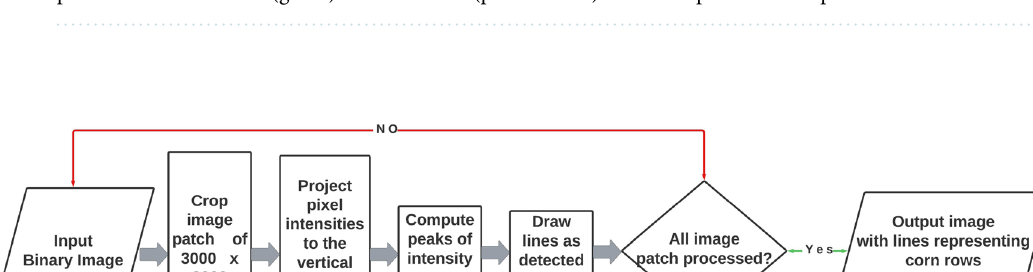
Figure 2. ( a ) DJI Matrice 600 Pro with a Sony Alpha 7R II, 42.4-megapixel RGB camera and Geosnap PPK system (top) mounted to it; ( b ) detailed view of Geosnap PPK system mounted on top of the aircraft; ( c ) iG4 GNSS base station that was kept in ground for stationary position; and ( d ) Corn field orthomosaic showing the placement of the SSWC (green) and no-SSWC (pink salmon) treatment plots in the experimental area.